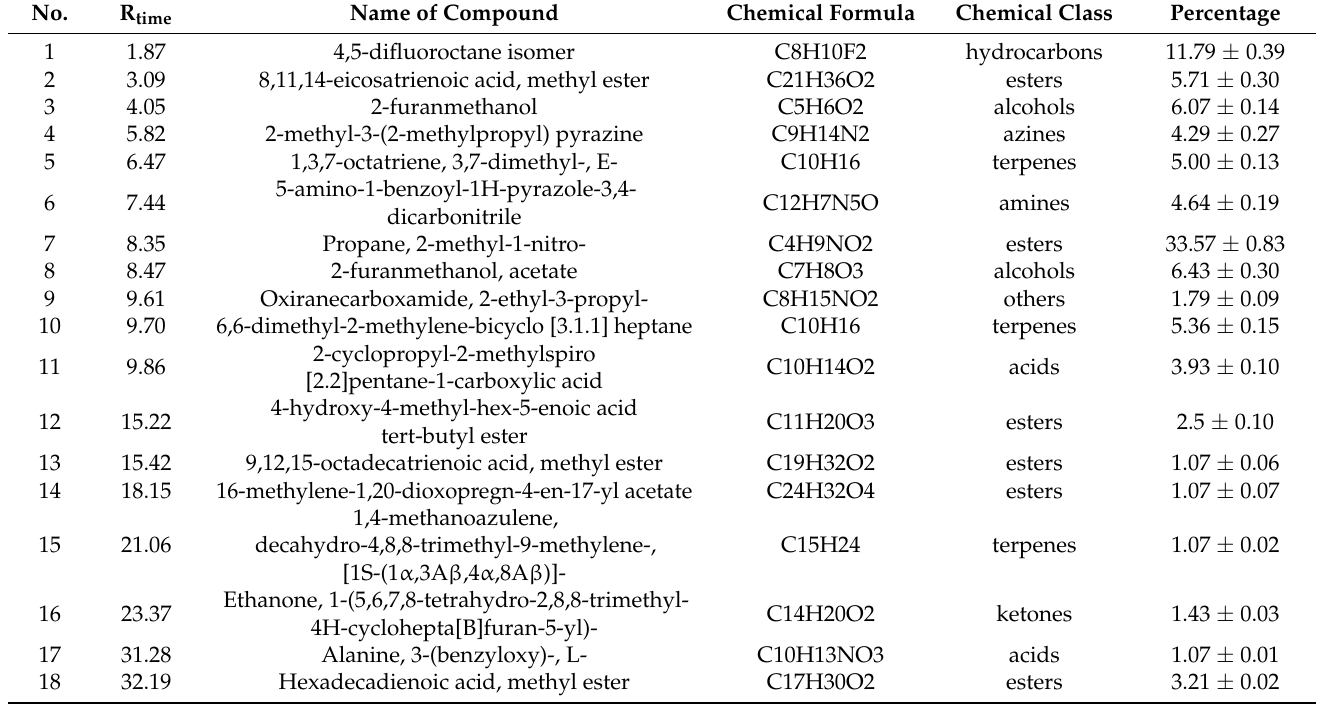
Table 1. Volatile compounds determined in the chromatographic analysis. %—percentage share of the compounds in the green coffee with standard